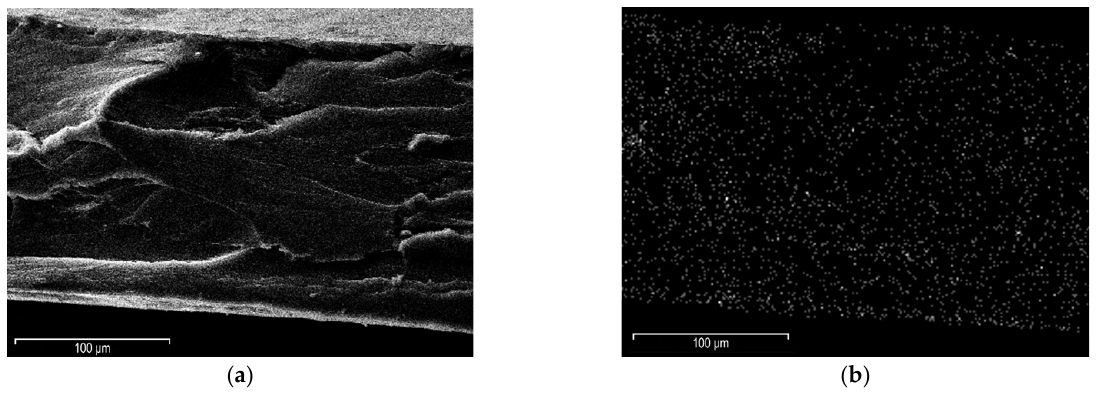
Figure 3. SEM micrographs of PE ‐ CNT F2 ‐ 3 fractured surface with a 100 k× magnification: cross ‐ section ( a ) and elemental map ( b ), with elemental fluorine as bright spots of the analyzed sample. TEM images of the PE ‐ CNT F2 ‐ 3 sample are reported in Figure 4 and show the spatial distribution of PFPE ‐ functionalized CNTs inside the UHMWPE matrix.